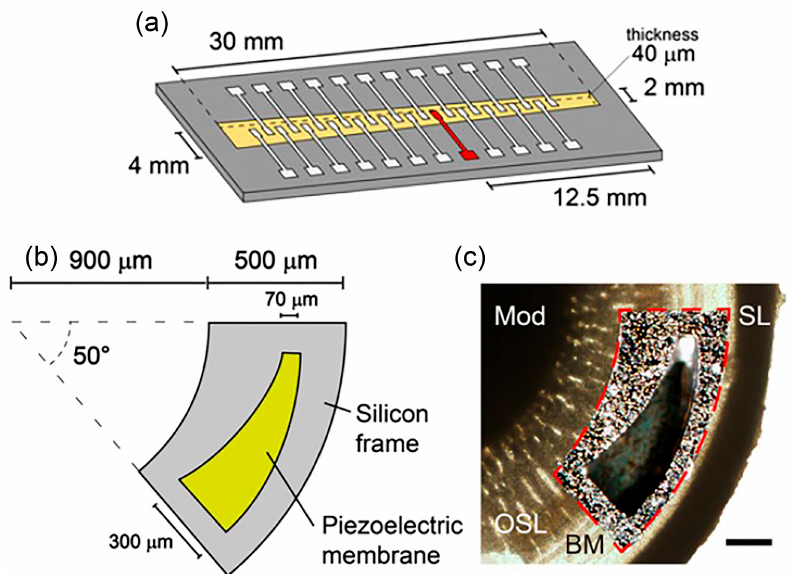
Figure 8. ( a ) The schematic diagram of PVDF membrane (yellow) with 24 aluminium top electrodes fabricated on a trapezoidal slit of a stainless plate. ( b ) The schematic drawing of the implantable P(VDF-TrFE) membrane and ( c ) the integrated optical image of the implanted P(VDF-TrFE) membrane in the basal turn of the cochlea [60].